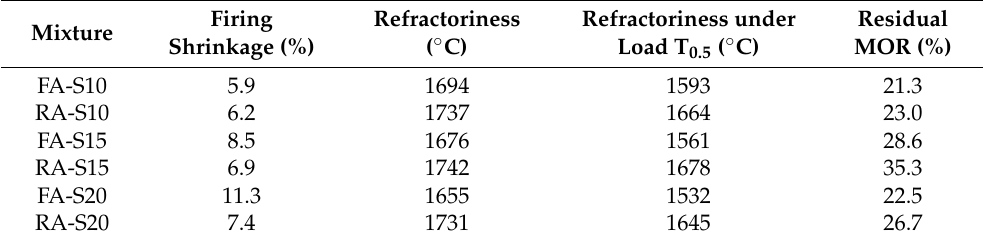
Table 5. Results of experiments to determine refractory and thermo-mechanical